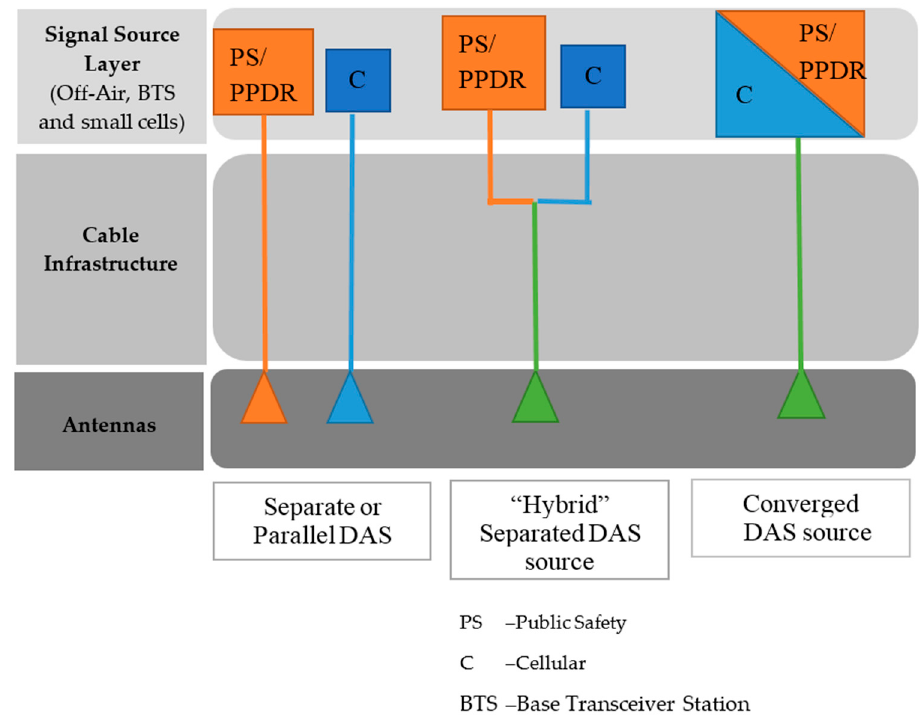
Figure 1. Three enabling DAS approaches for commercial cellular and PS indoor coverage.